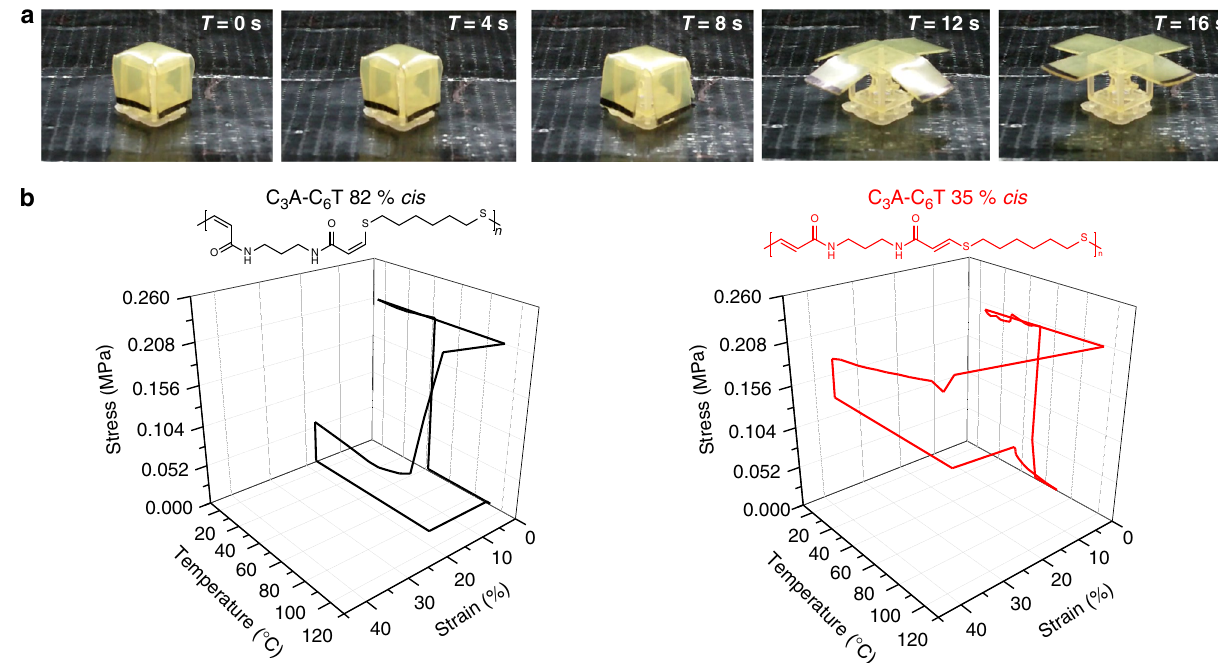
Fig. 3 Shape memory behaviour. a Visual demonstration of shape memory for C 3 A-C 6 T 82% by heating to 120 °C. Note: Sample edges were darkened with ink to aid in visualising movement. b DMA analysis of shape memory behaviour for C 3 A-C 6 T (high cis and low cis